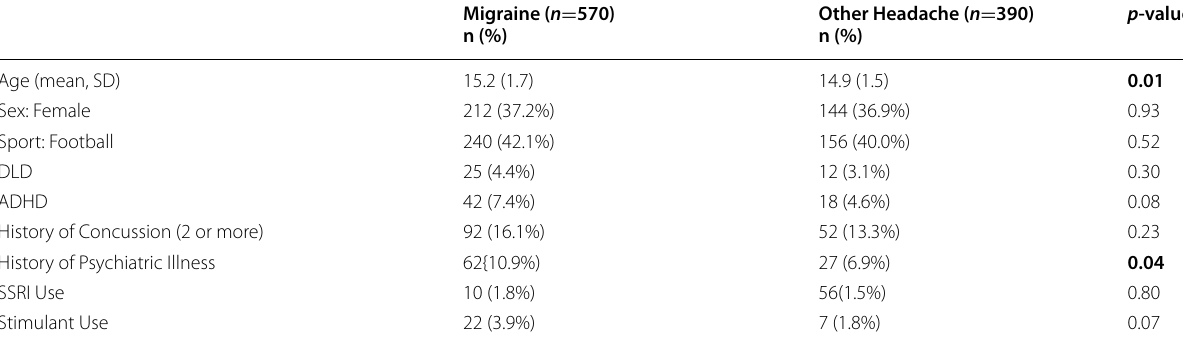
Table 4 Demographics of Subjects with Prior Migraine Treatment vs Treatment for Other Headache